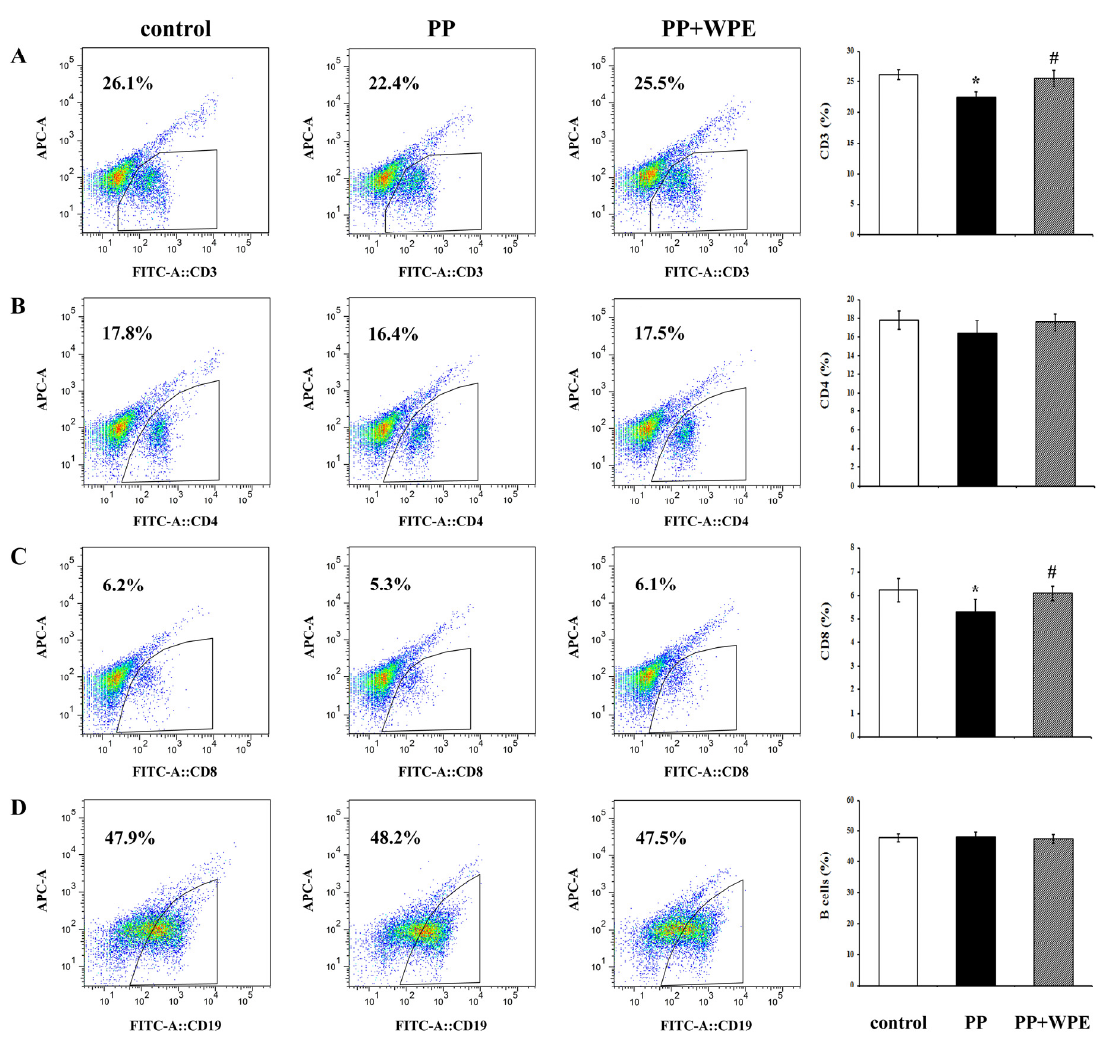
Figure 2. Percentages of various lymphocyte cell types as determined using flow cytometric analysis. ( A ) CD3 + T ‐ cells; ( B ) CD4 + T ‐ cells; ( C ) CD8 + T ‐ cells; and ( D ) B ‐ cells in cells exposed to medium only (control), PP (10 − 4 M), or WPE (1.0 μ g/mL), together with PP for 48 h. Results shown are means ± SD